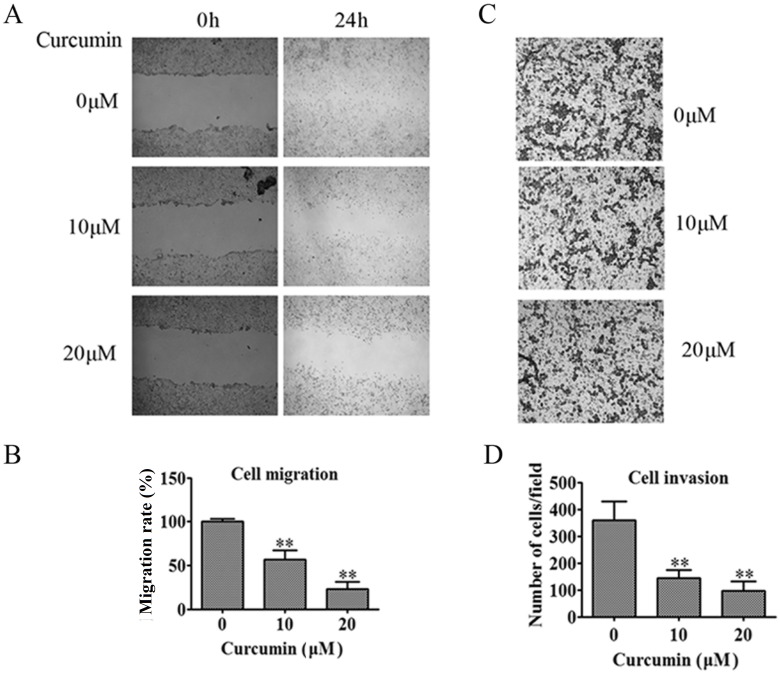
Curcumin inhibits 95D cell migration and invasion.(A) 95D confluent monolayer cells are scratched with a pipette tip and then treated with 10 μM or 20 μM curcumin. Representative images show the inhibitory effect of curcumin on 95D cell at 24 h. (B) The gap distance is quantitatively evaluated using the Image J software. (C) The invasion ability of 95D cell is determined by invasion assay. Cells in low surface of the Boyden chamber are stained and photographed under a light microscope at × 100 magnification. (D) The invading cells are quantified by counting the number of stained cells under a light microscope at × 200 magnification. Columns, mean from three different experiments with 3 duplicates; *, p < 0.05; **, p < 0.01 compared with 0 μM curcumin group.